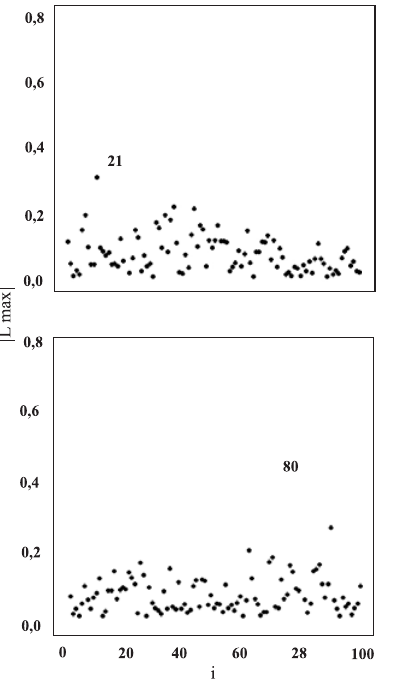
Figure 4. Index plot of |L Figure 2. Index plot of |L | for simulated data | for simulated data max max using the exponential 0-10-20 (left side) and 0- using the Gaussian 0-10- 20 (left side) and 0-10- 10-60 (right side) covariance function. 60 (right side) covariance function.